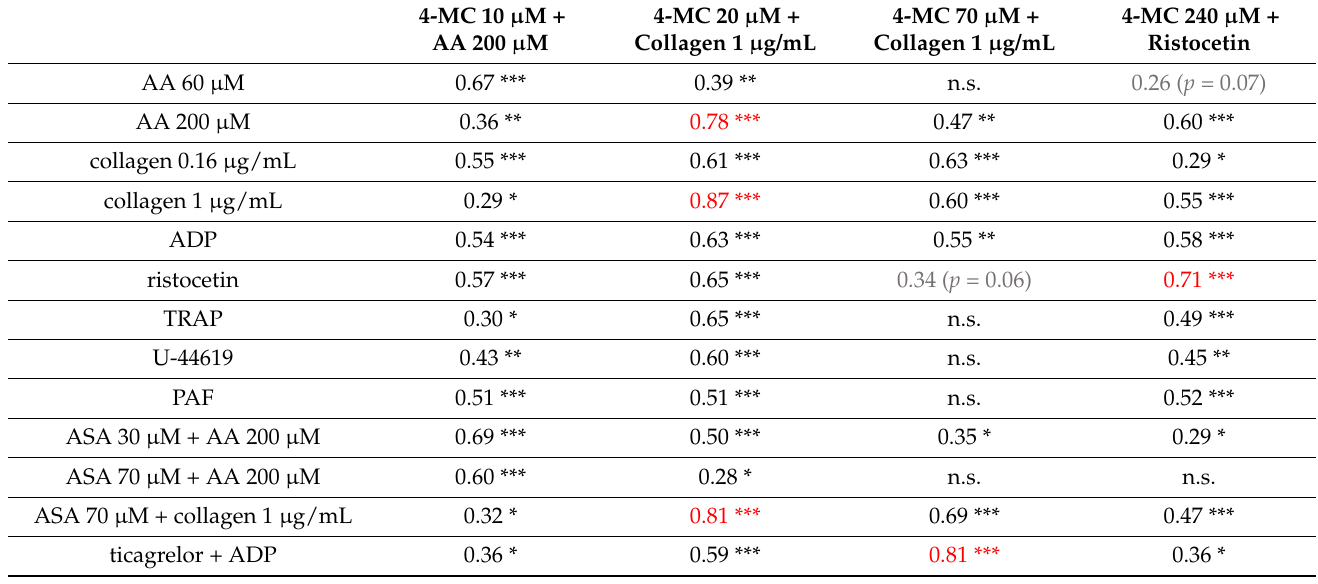
The data show the Pearson correlation coefficients. n.s.—nonsignificant, * p < 0.05, ** p < 0.01, *** p < 0.001. The highest coefficients are highlighted in red. Nearly significant associations are in grey. AUC—area under the curve.